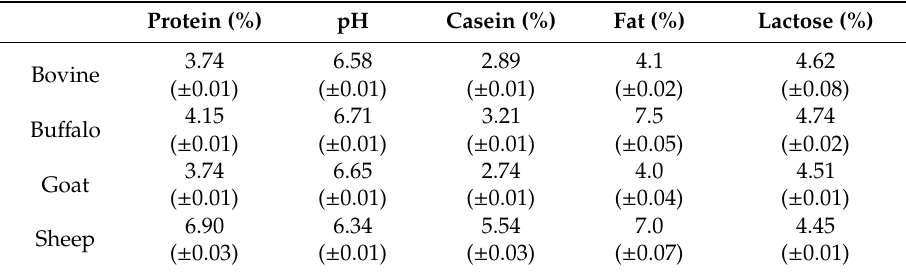
Table 1. Chemical compositions of the milk samples used for the coagulation experiments. Protein (%) pH Casein (%) Fat